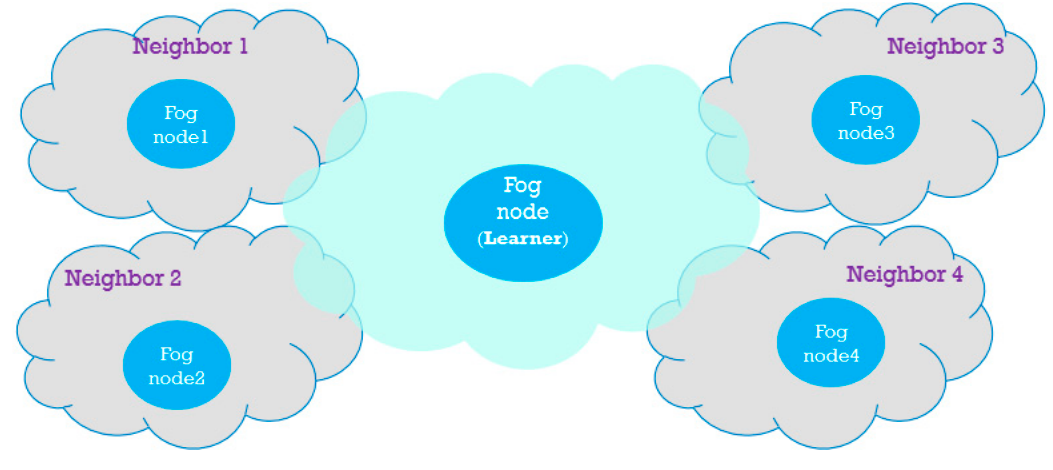
Figure 1. Five instances of fog fragments in a neighborhood.